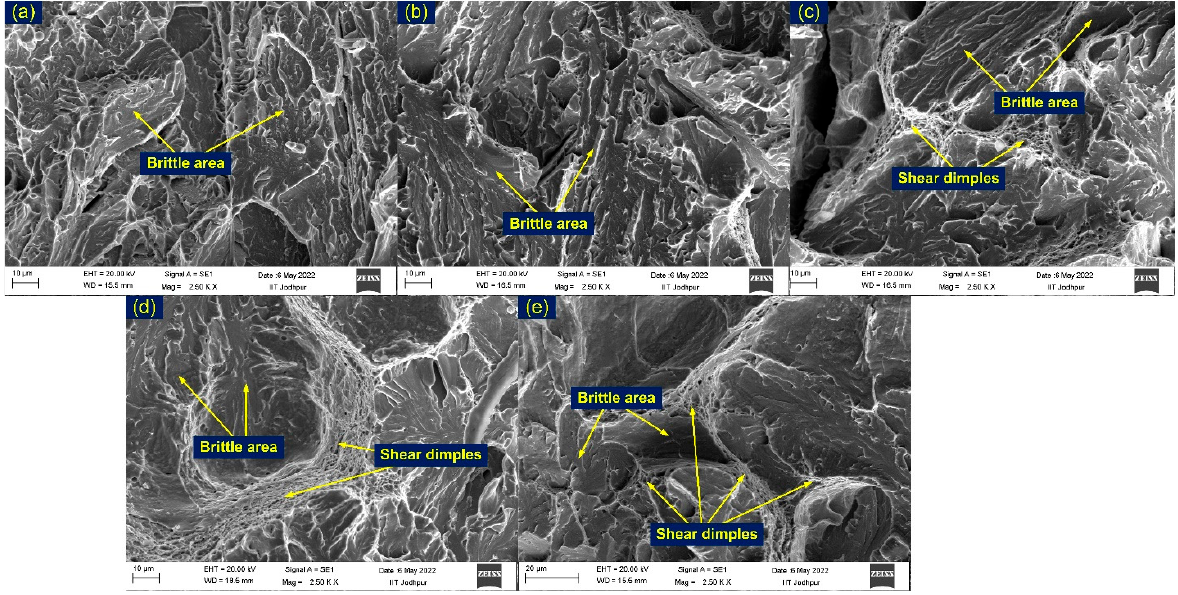
Figure 19. SEM image of fractured impact tested specimens: ( a ) AW, ( b ) T1, ( c ) T2, ( d ) HT1, ( e ) HT2. Tensile test results are depicted in Table 4. Tensile specimens before and after fracture are given in Figure 20a,b, while Figure 20c shows the stress–strain curve. The specimen for the AW test showed the fracture in the P92 BM zone with tensile strength (TS) of 751 MPa. The failure of the tensile specimen from the P92 BM instead of the WFZ ensured that the joint was safe for USC boiler application. The TS value measured near the P92 BM was 758 MPa. However, for the AW joint, % elongation (13%) measured lower than that of the P92 BM (33%). The lower value might be due to the presence of the WFZ and HAZ in the gauge area of the specimen. The TS values were 683 MPa, 701 MPa, 711 MPa and 690 MPa for T1, T2, HT1 and HT2, respectively. The fracture in each condition was measured in over-tempered BM. TS for the heat-treated specimens measured lower than for the BM and AW joint. This might be due to the over-tempering of the martensite in the P92 BM. Table 4. Tensile properties of P92 steel and welded joint for AW and heat-treated state.